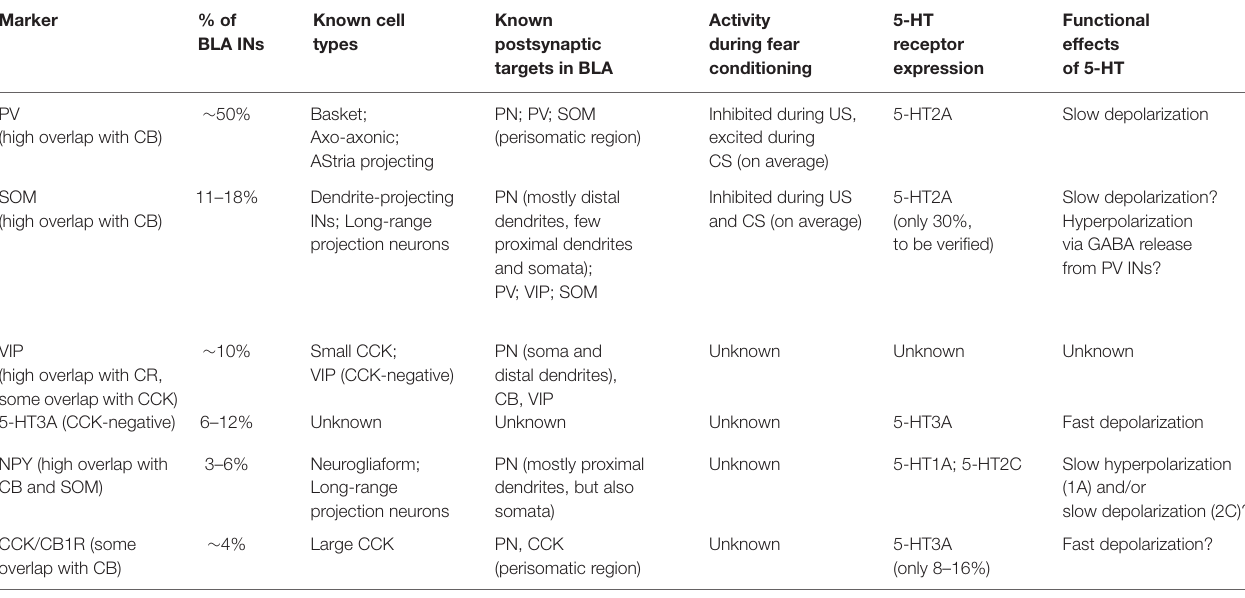
TABLE 1 | Features and 5-HT receptor expression of main BLA GABAergic classes.